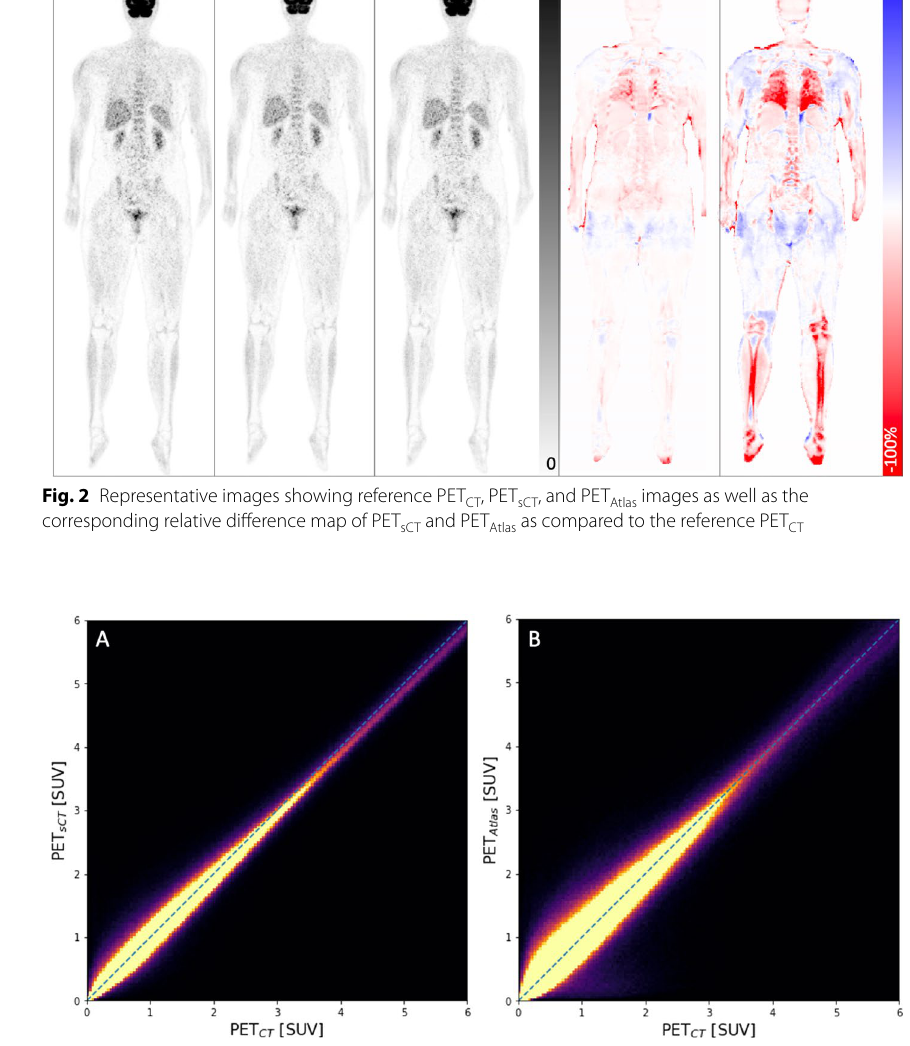
1.5% 14.1% in SUV values for all the voxels within the body contour across all ±